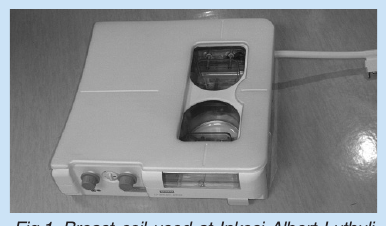
Fig.1. Breast coil used at Inkosi Albert Luthuli Hospital. Both breasts can be imaged simulta- neously in the prone position.